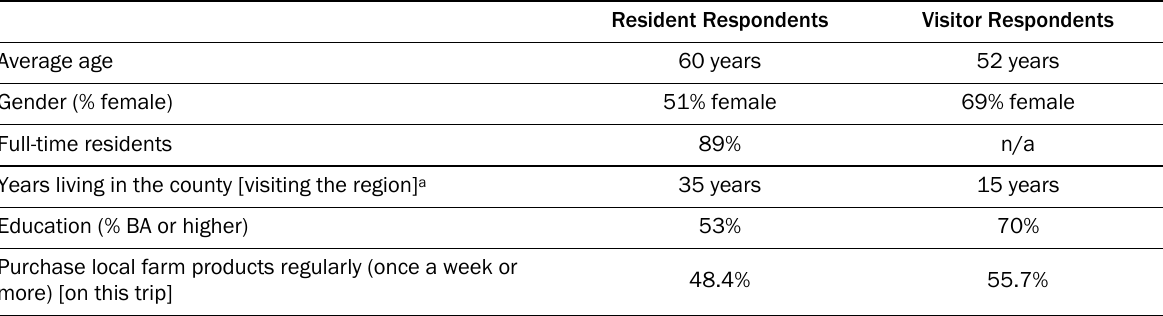
Table 2. Demographic Characteristics of Survey Respondents